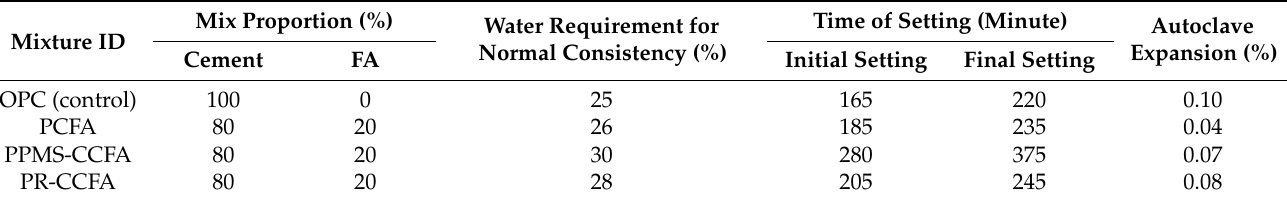
Table 3. Water demands and setting time of fly ash substituted cement paste.